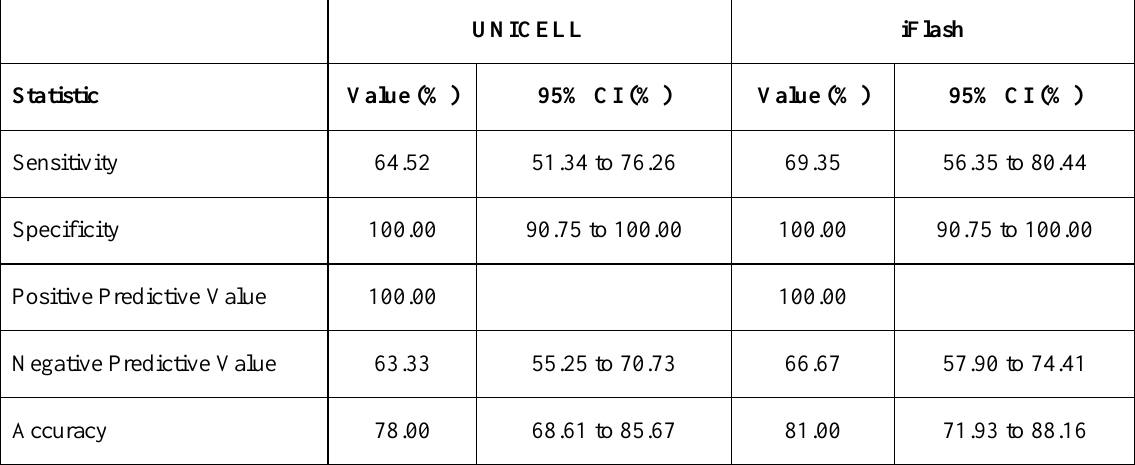
Table 2. The performance accuracy of both I Flash and UNICELL in relation to RT-PCR.